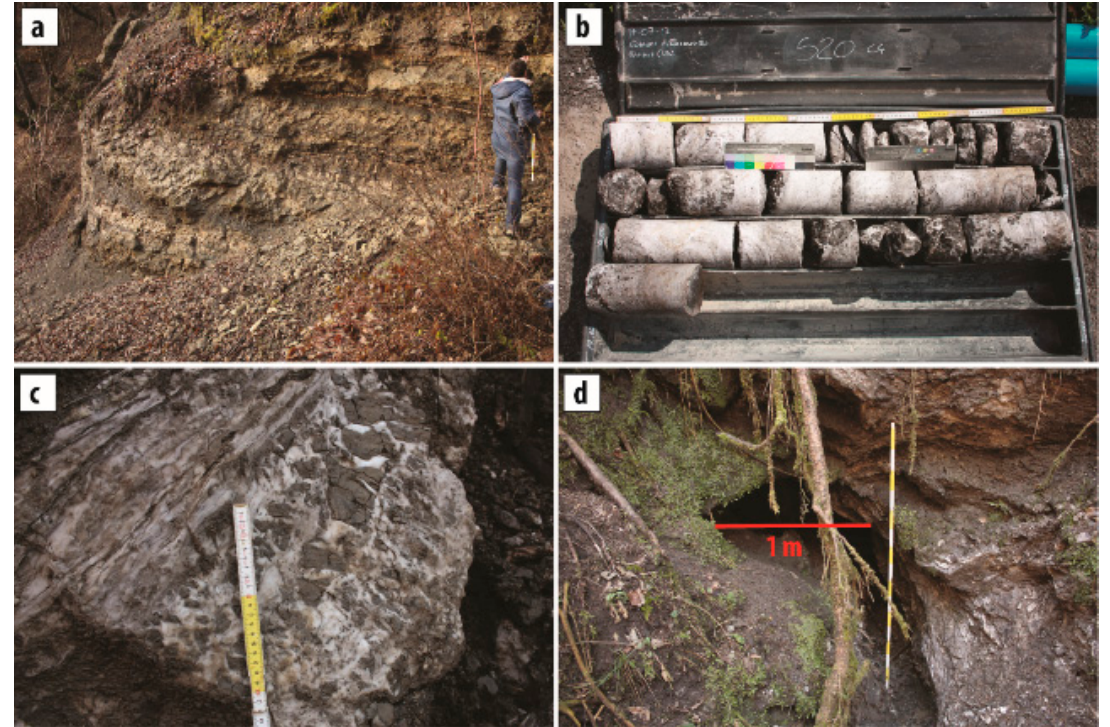
Figure 3. ( a ) silt stones and red shales from Membro a peliti rosse ; ( b ) core-drilling samples collected while drilling PZ20 piezometer into the Membro a gessi e dolomie grigie ; ( c ) particular of a warped gypsum with marls fragments; ( d ) cave entrance (in red the dimension) present along one of the small stream with no name, tributary of the Rio Quinis stream, a surface drainage of the (Tagliamento River). Photo credit: E.